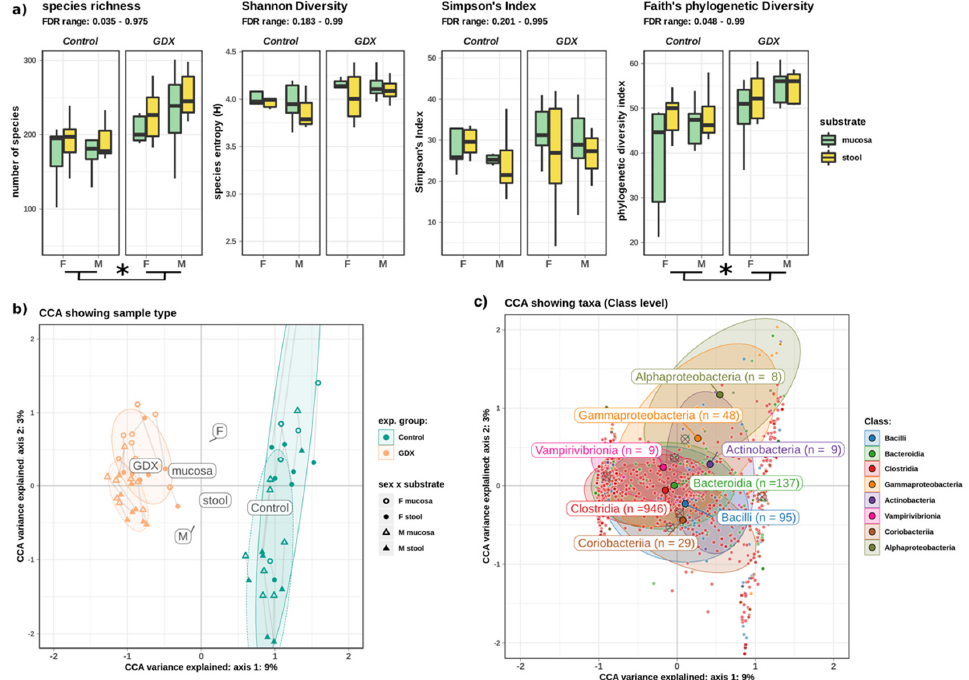
Figure 3. Microbial diversity. ( a ) Alpha diversity (richness and phylogenetic diversity) was increased following gonadectomy, but it did not differ significantly between sexes or substrates. ( b ) Beta diversity (CCA of sample composition), showing the significant influence of both experimental group and sex, as illustrated by the strong separation of labels (centroids) for F and M controls, which is resolved by GDX. The substrate had a non-significant effect, as illustrated by the co-location of labels near the origin. ( c ) The same CCA showed taxa as points closest to samples where they were most abundant (e.g., Gammaproteobacteria tended to be more abundant in control-F). Crossed circles indicate location of group centroids. Paired samples are joined by a line. Asterisk (*) denotes significant difference at FDR < 0.05, whereas a horizontal bracket indicates that the difference is between the GDX and control overall. Abbreviations: F: female; M: male; GDX: gonadectomy; CCA: constrained correspondence analysis.